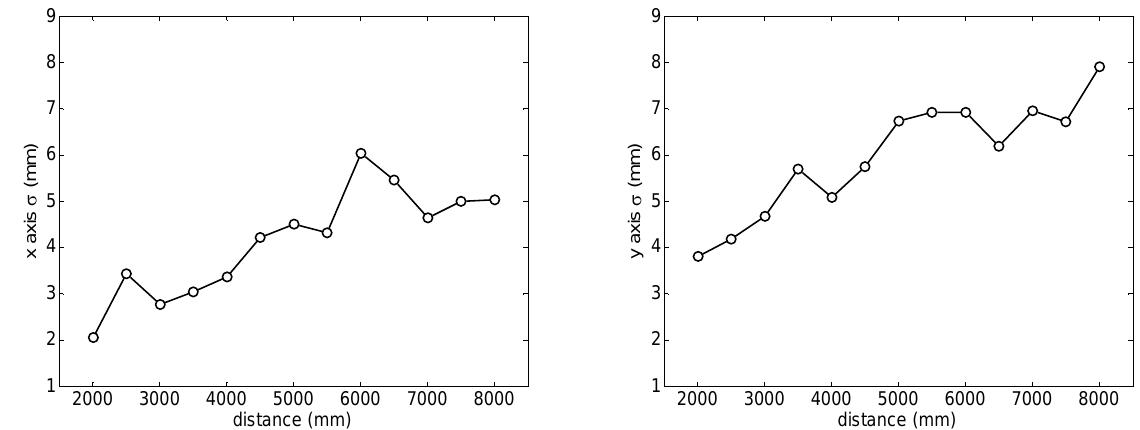
Figure 10. Example of trajectory of the legs estimated from the raw